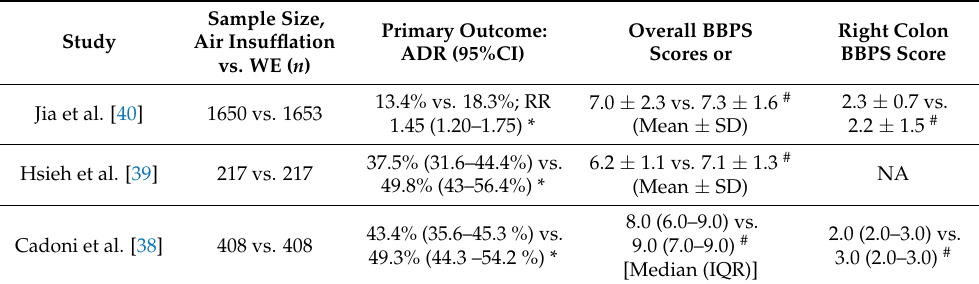
Table 5. BBPS scores in key randomized controlled trials comparing ADRs between WE and air